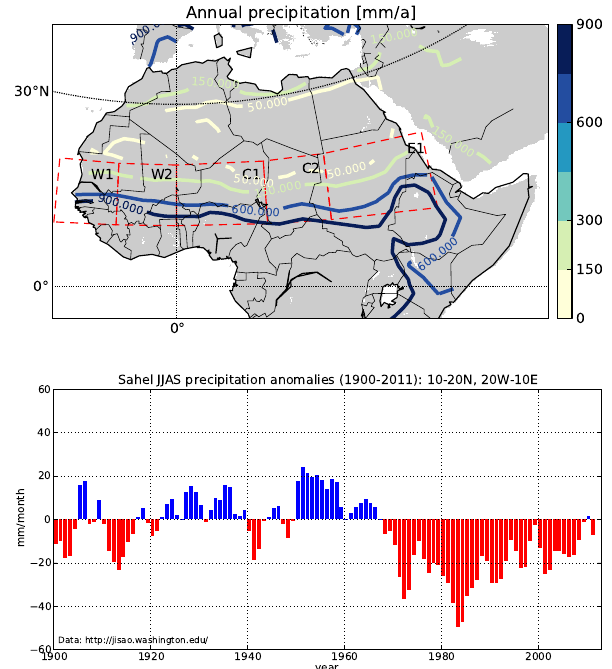
Fig. 1. Annual mean precipitation [ mmyr − 1 ] in the Sahelian region. Bounding boxes for regions used for detailed analysis extend between 10 ◦ N and 20 ◦ N. Longitudinal extend is given as: W1 (20 ◦ W–10 ◦ W), W2 (10 ◦ W–00 ◦ W), C1 (00 ◦ W–15 ◦ E), C2 (15 ◦ E–25 ◦ E), E1 (25 ◦ E–40 ◦ E) (Data: GPCP) (top). Sahel rainfall anomalies for the period 1900–2011 and the region from 10 ◦ N–20 ◦ N and 20 ◦ W–10 ◦ E (Data from http://jisao.washington.edu/), Ali and Lebel (2009) (bottom).